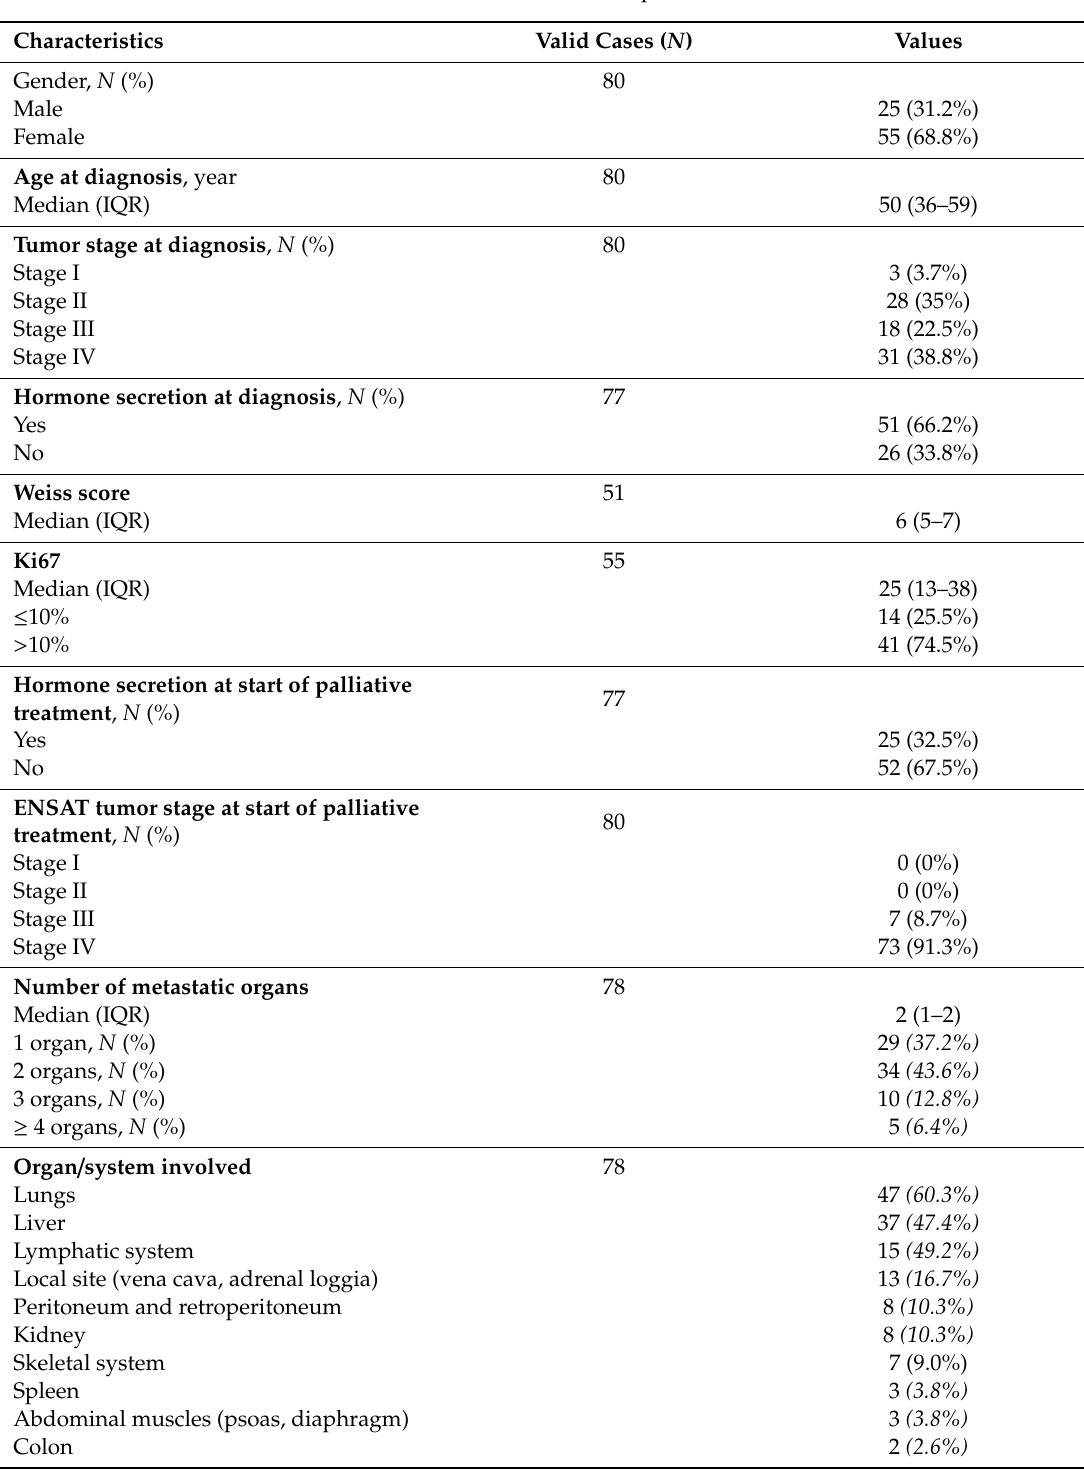
Table 1. Baseline features of